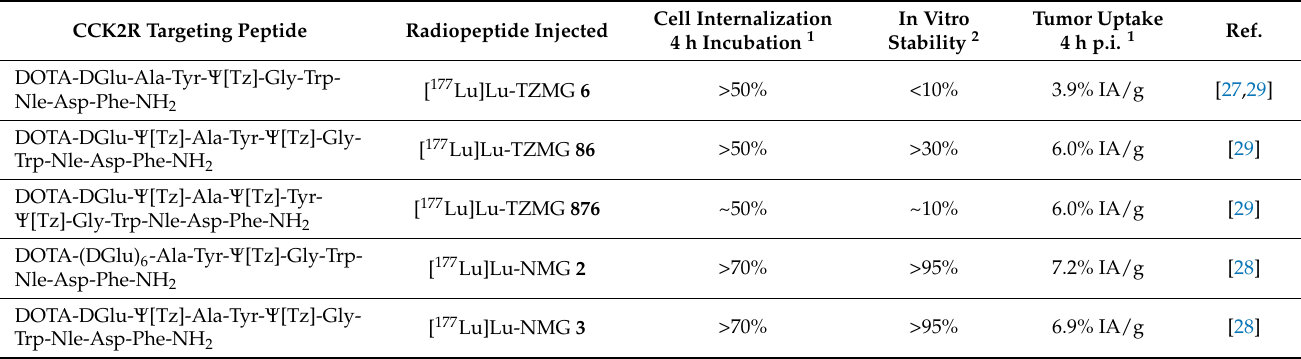
Table 2. Targeting properties of selected radiolabeled MG analogs with amide-to-triazole substitutions. CCK2R Targeting